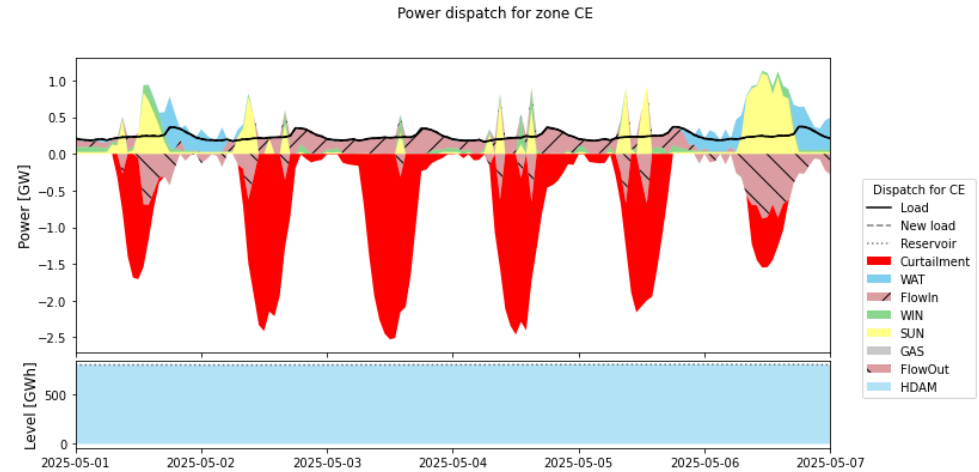
Figure 21. Low-Penetration Scenario 1(H)—South zone (1–7 May 2025).